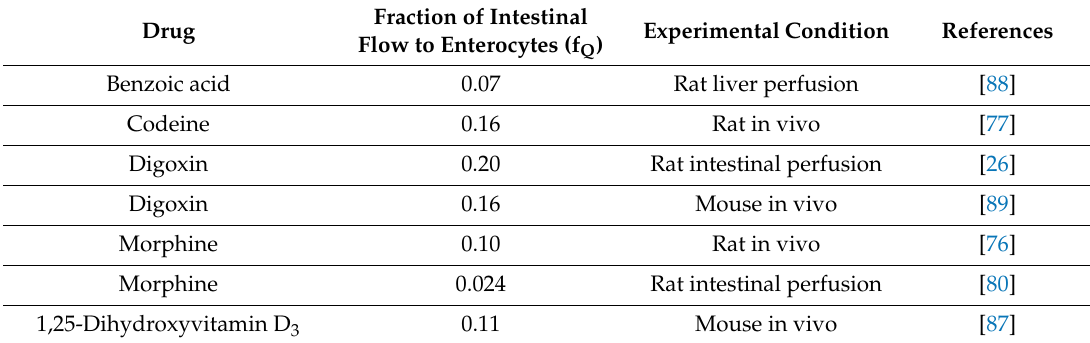
Table 2. Fitted values of f Q in rodents in vivo and in perfusion preparations. Fraction of Intestinal Experimental Condition Drug Flow to Enterocytes (f Q ) Benzoic acid